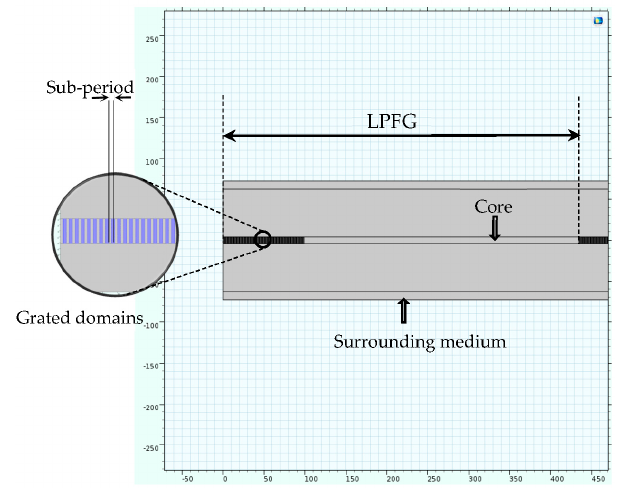
Figure 6. Geometrical depiction of the numerically modeled single mode fiber.